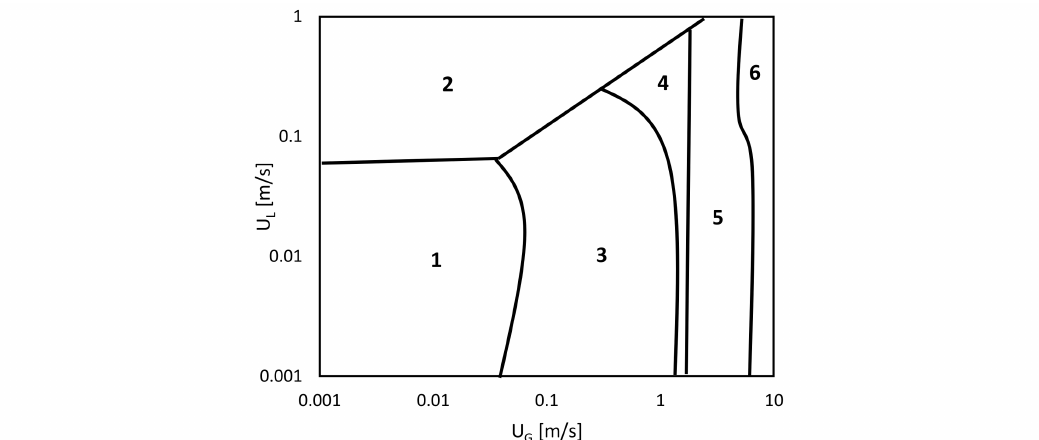
Figure 12. Flow regime maps from the previous